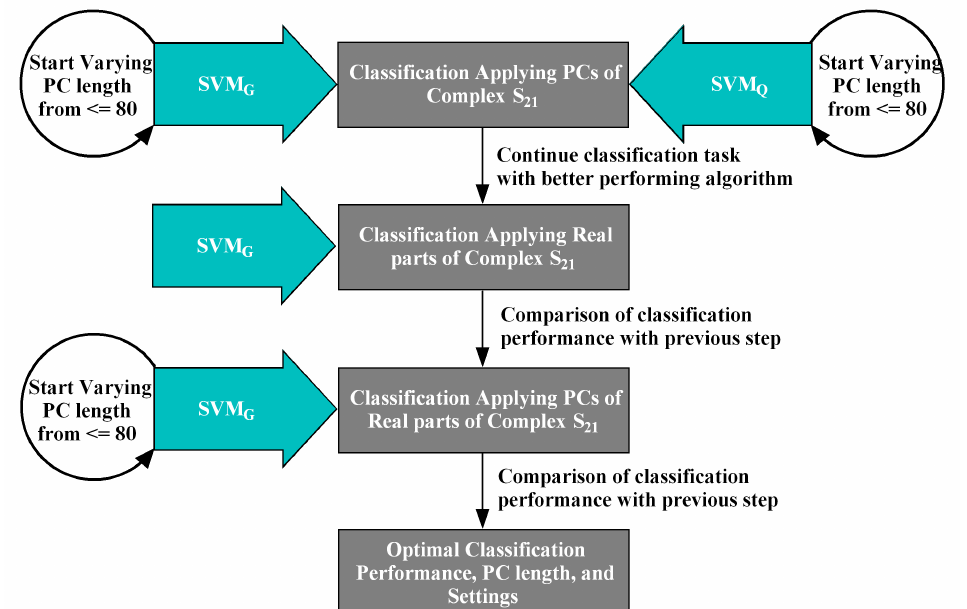
Figure 3. A Flowchart of the classification stages involved in the proposed ML experiment. SVM G and SVM Q have been trialled and compared, employing PCs of the complex S 21 data (raw data). The investigation continued with SVM G , comparing its performance with SVM Q . Subsequently, real parts and PCs obtained from the real parts of the complex S 21 have been employed in the second and third stages respectively to classify the NF-WF signals by SVM G . The optimal performance attained in the third stage applying PCs of real parts of complex S 21 with SVM G